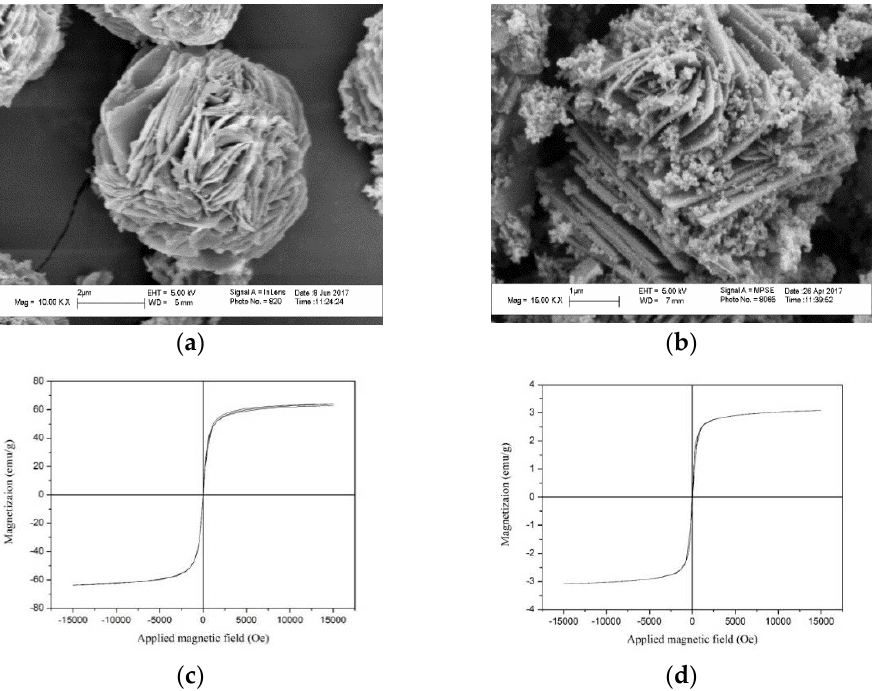
Figure 3. SEM images of ( a ) MAG [48], and ( b ) MAG–Fe 3 O 4 ; and hysteresis loops of ( c ) Fe 3 O 4 , and ( d ) MAG–Fe 3 O 4 .